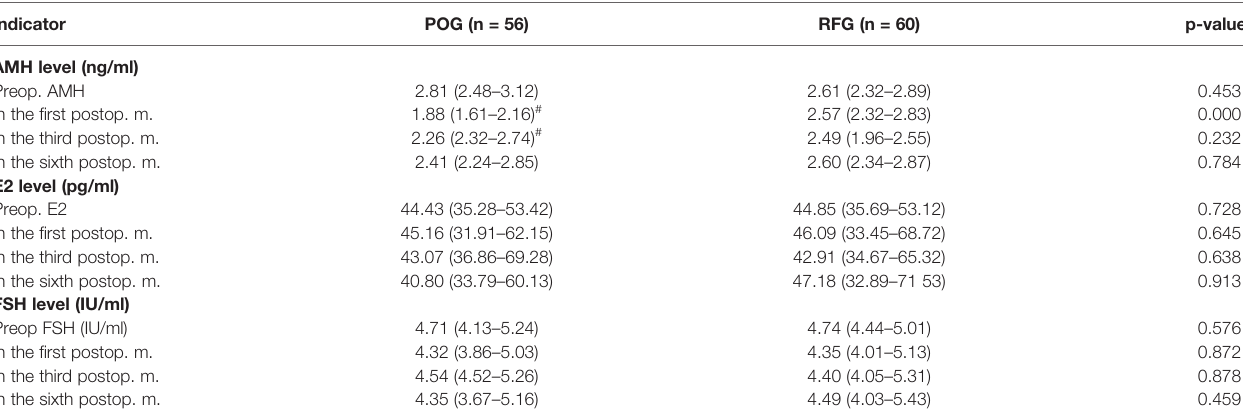
*As indicated by one-way ANOVA, # As indicated by one-way ANOVA, the difference was statistically signi fi cant when compared with preoperative. AMH, anti-Müllerian hormone; E2, estradiol; FSH, follicle-stimulating hormone; POG, a postoperative observation group that underwent laparoscopic unilateral ovarian cystectomy; RFG, a referent group that did not undergo surgery; OARI, ovarianarterial resistance index; AFC, antral follicle count; Preop, preoperatively; in the fi rst postop. m, in the fi rst monthpostoperatively; inthe third postop. m., in the third month postoperatively; in the sixth postop. m., in the sixth month postoperatively; (), The value is 95% con fi dence